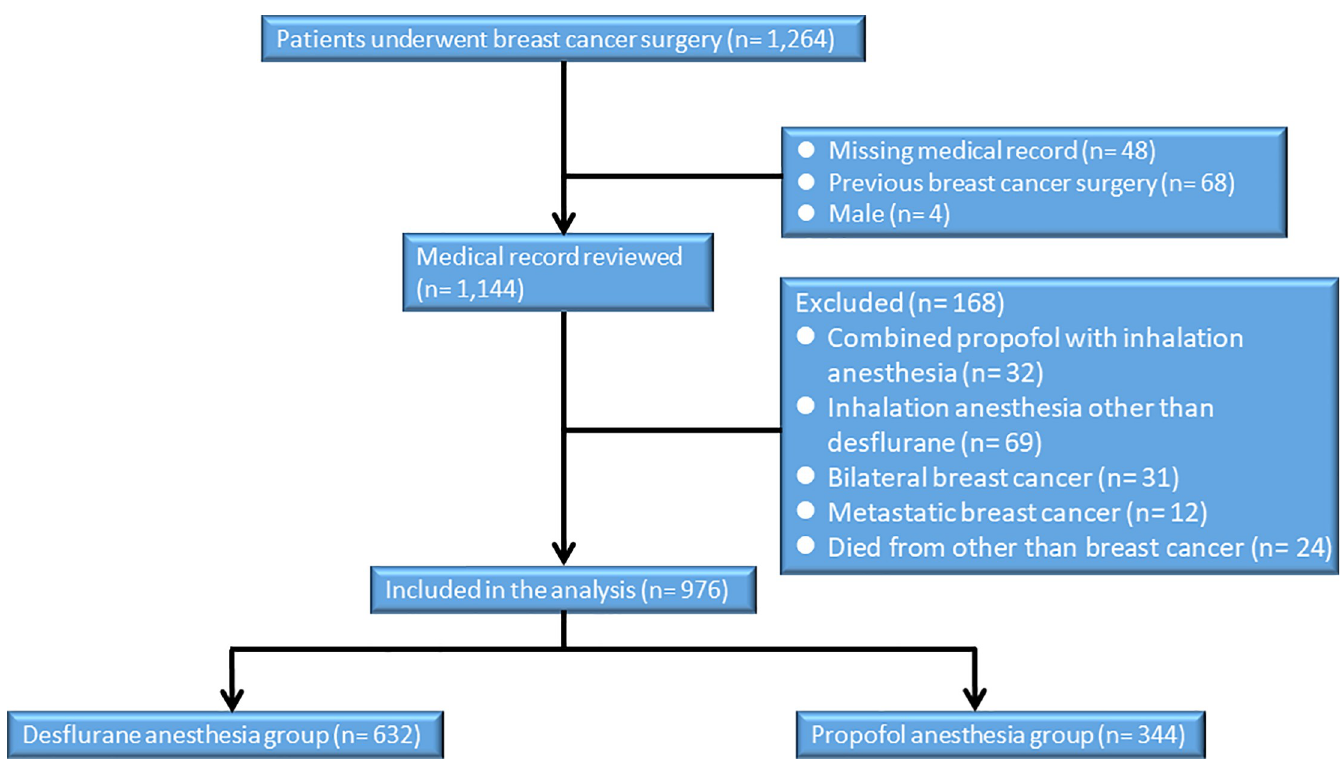
Fig 1. Flow diagram of the study